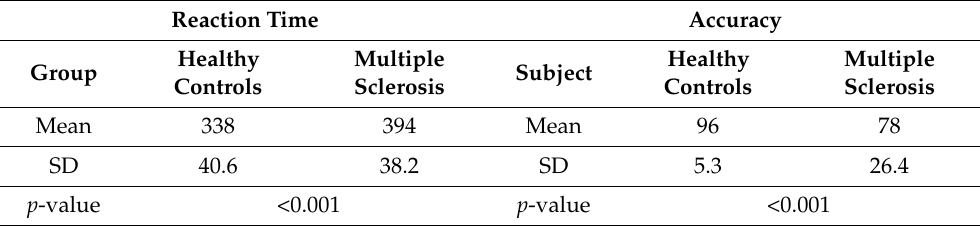
Table 2. Behavioral